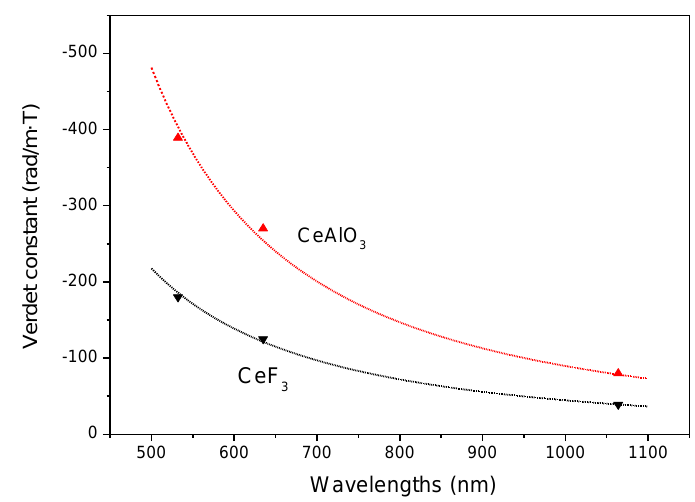
Figure 8. Verdet constant as a function of the wavelength for CeAlO 3 and CeF 3 crystals.